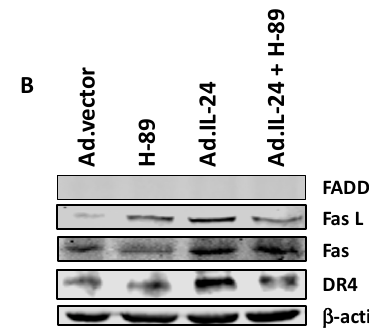
Figure 5. The inhibition of PKA blocks IL-24 activation of extrinsic apoptosis. ( A ) MCF-7 cells were infected with either Ad.vector (control) or increasing concentrations of Ad.IL-24 (25, 50, 100 pfu per cell) for 72 h. Western blot analysis was performed with antibodies for FasL, Fas, FADD, DR4, and β -actin. ( B ) MCF-7 cells were infected with either the Ad.vector (control) or Ad.IL-24 at 100 pfu/cell, and either untreated or treated with 10 µ M H-89 for 72 h. Western blot analysis was performed with antibodies for FasL, Fas, FADD, DR4, and β